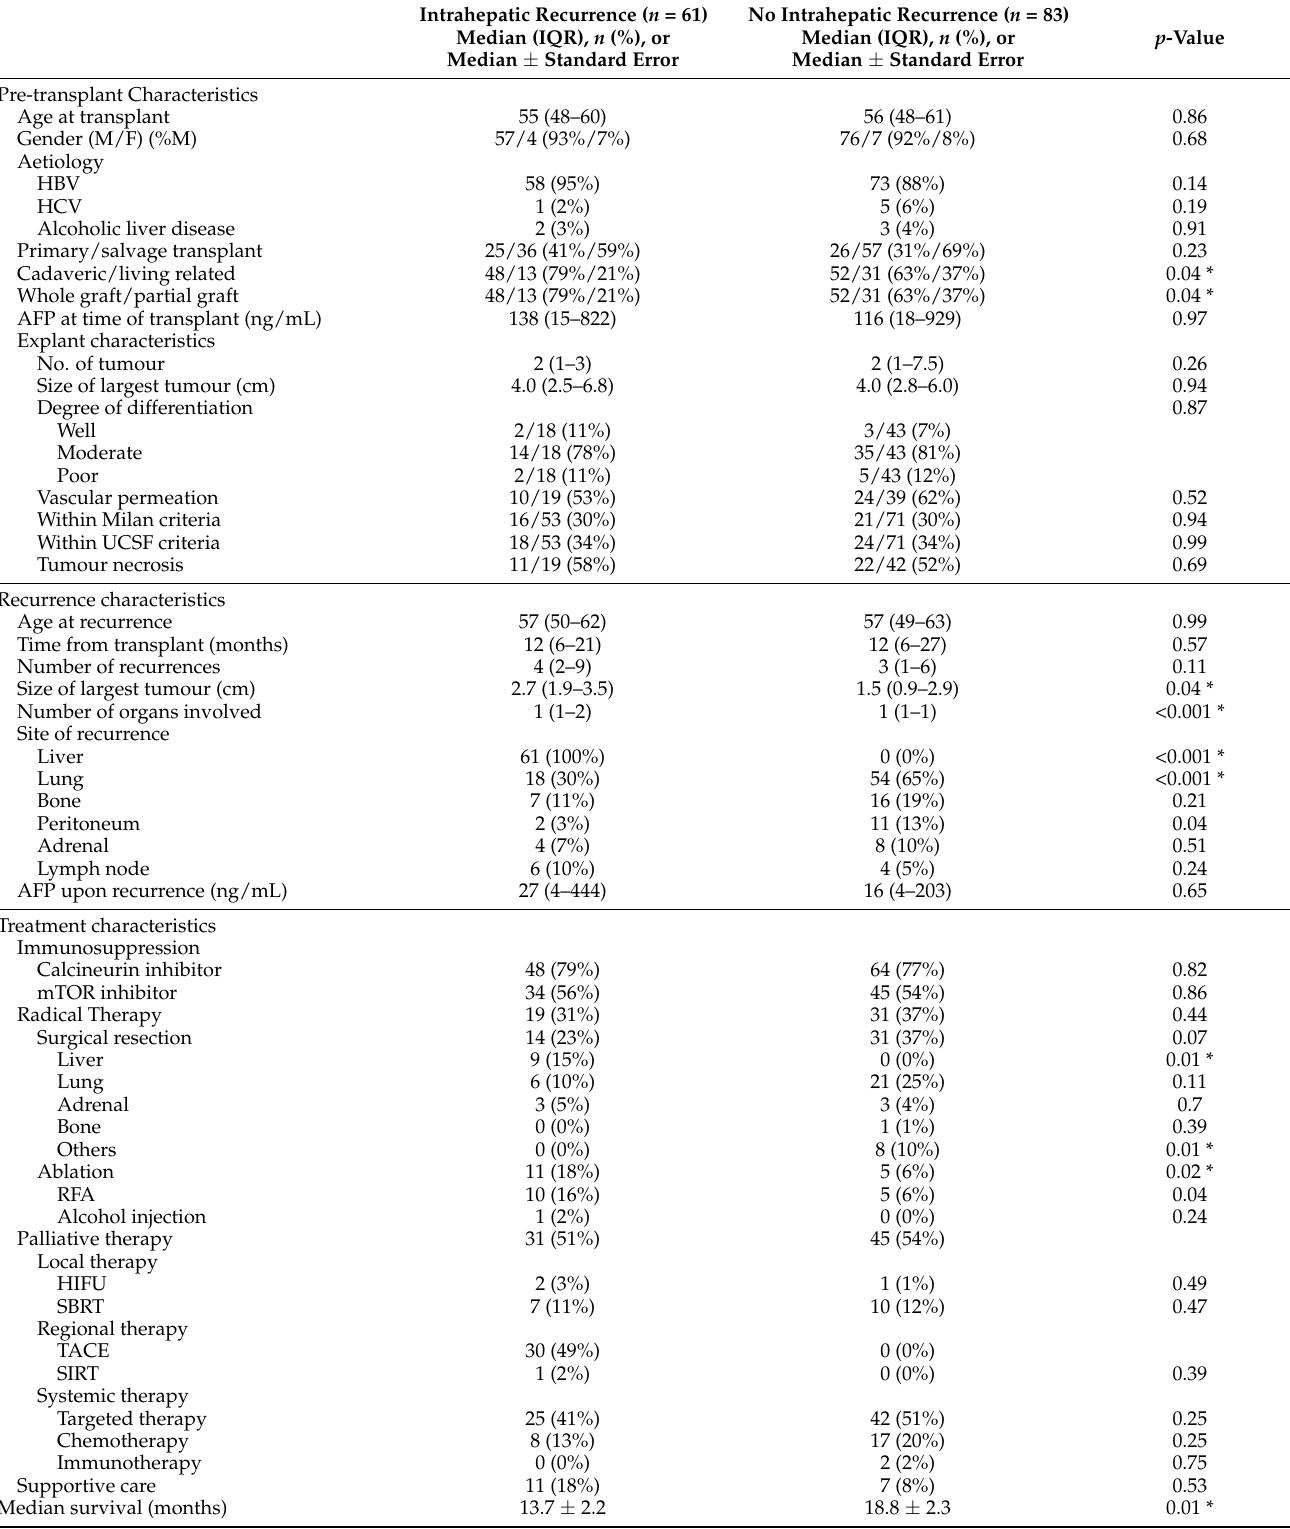
Table 5. Characteristics of patients with and without intrahepatic